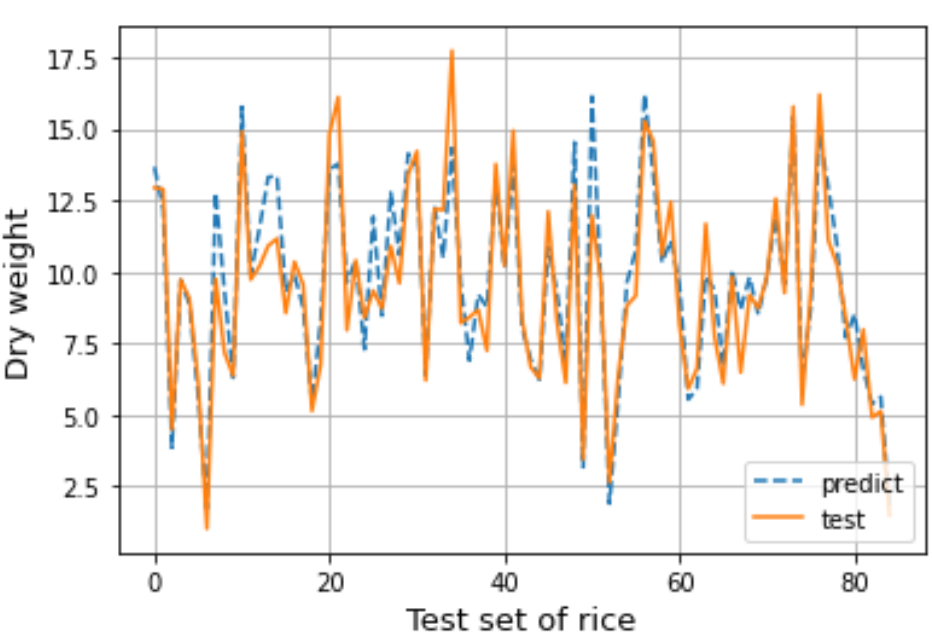
Figure 8. Fitting renderings of the random forest model.